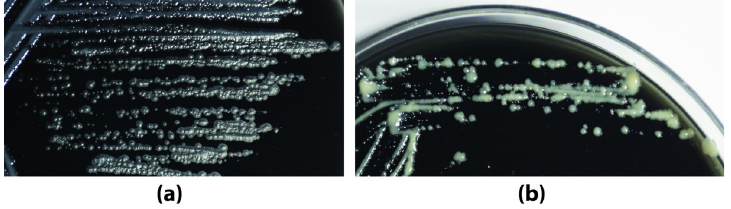
Fig 1. M . abscessus isolates. Isolated and sub-cultured rough (a) and smooth (b) M . abscessus colonies grown on BHI agar plates containing 7% calf serum and 0.4% charcoal after incubation at 37˚C for 7 days in microaerobic